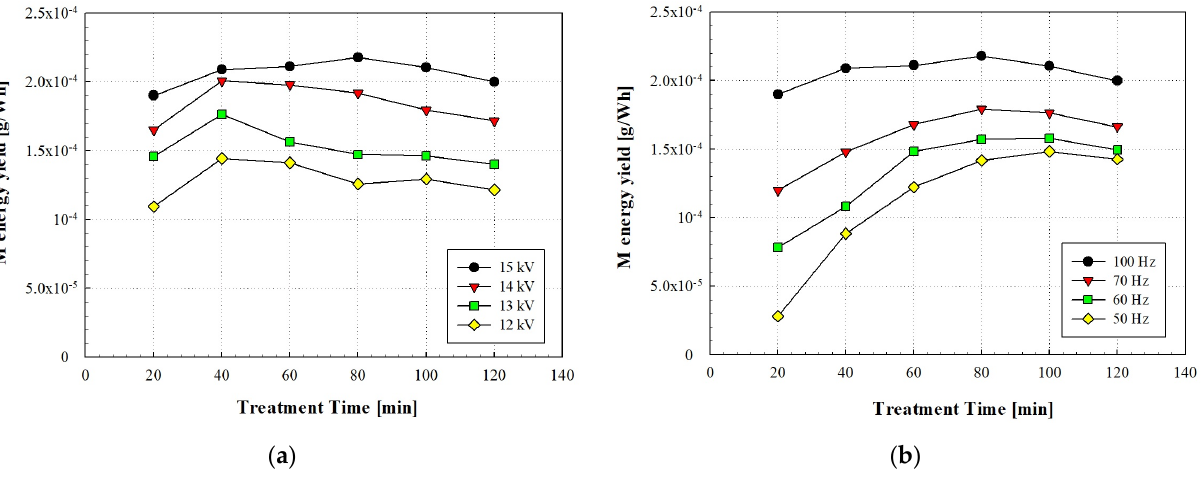
Figure 11. ( a ) M energy yield by treatment time based on the voltage at 100 Hz ( b ) M energy yield by treatment time based on the frequency at 15 kV.